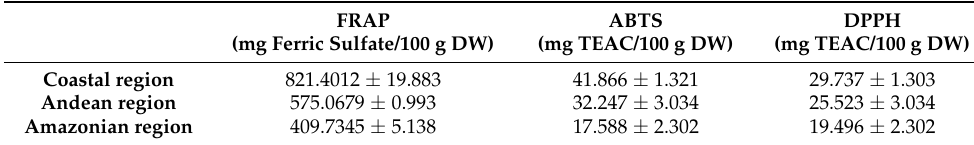
Table 5. Antioxidant activities in Moringa leaves from three Ecuadorian